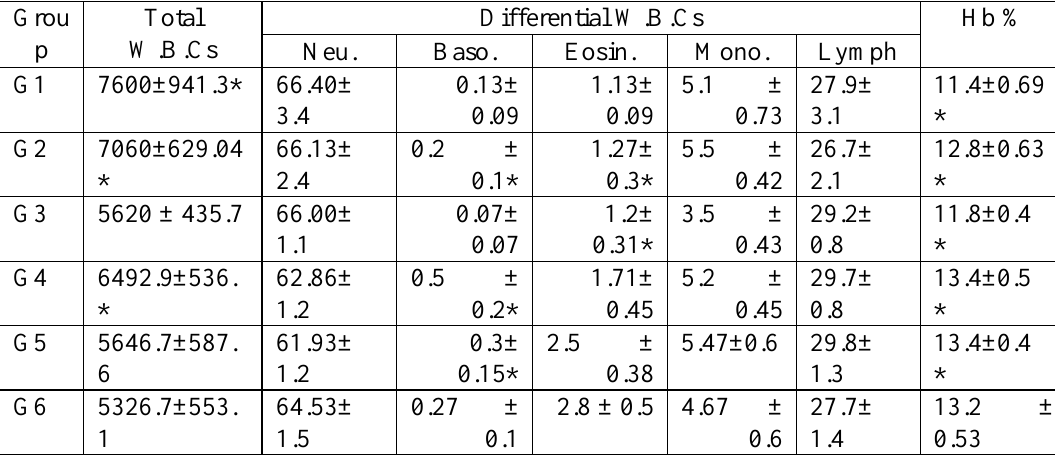
Table (2): Hematological Results obtained for all groups.